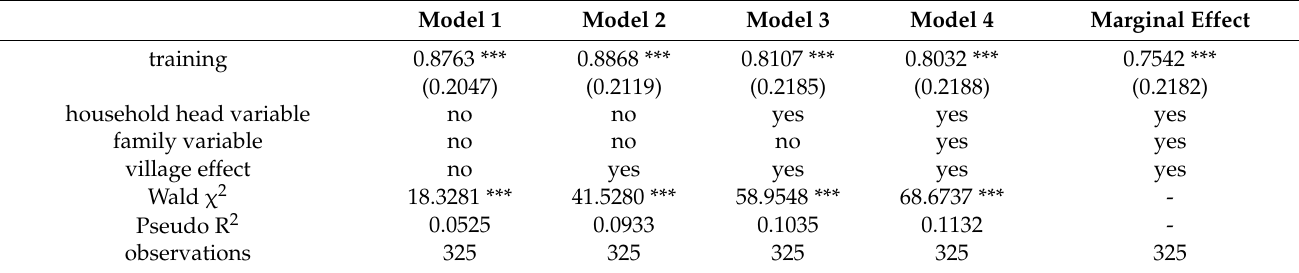
Table 3. The impact of training on the extent of farmers’ earthquake preparedness. Model 1 Model 2 Model